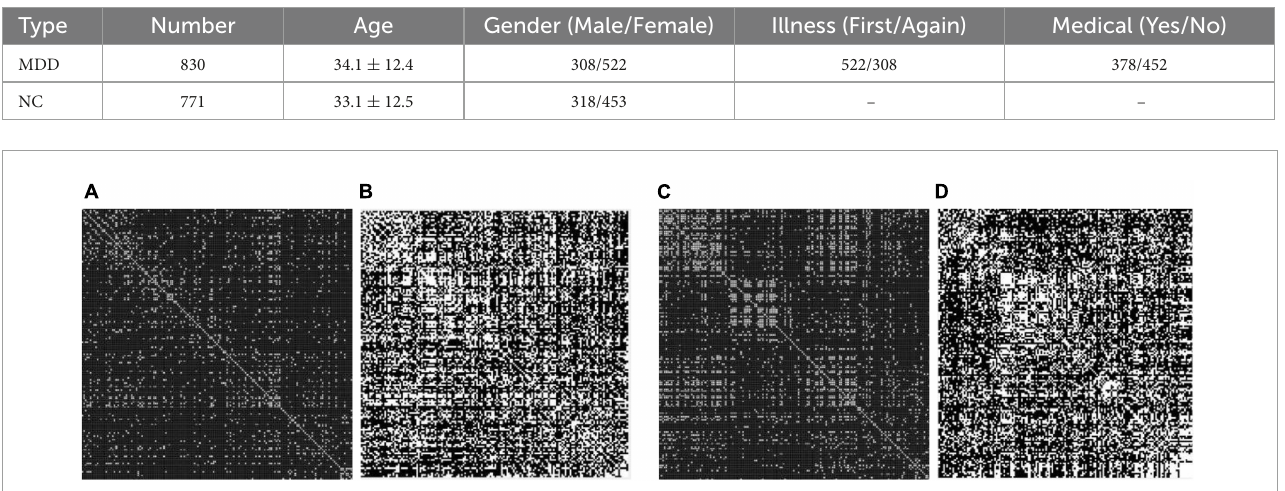
TABLE 1 Clinical information table on subjects.